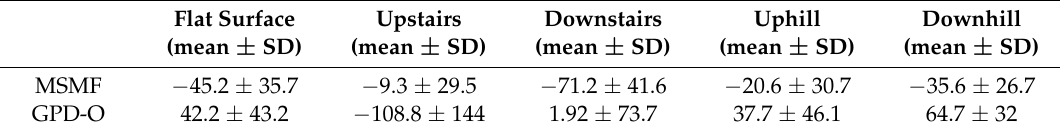
Table 5. Timing error in TC event for MSMF and GPD-O algorithms across different terrains (with respect to push